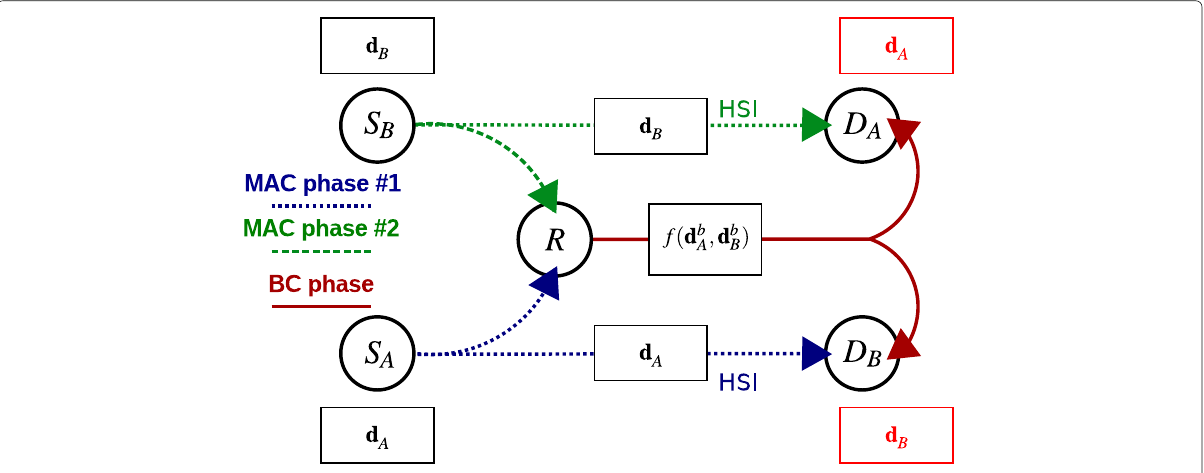
Fig. 19 Three-step reference scenario with conventional